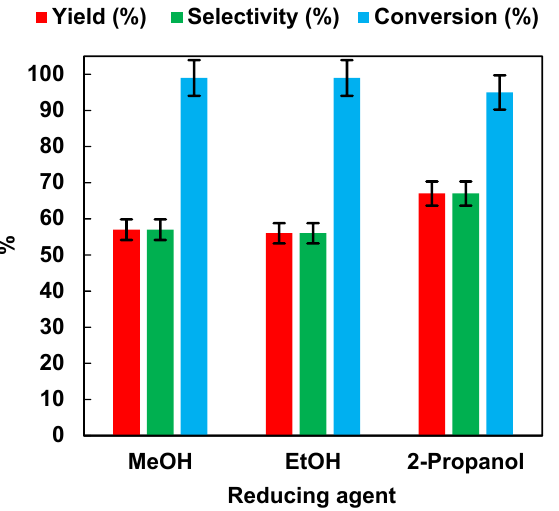
Figure 3. Effects of different hole scavengers on AN yield, AN selectivity, and NB conversion after 45 min of irradiation time. Error bar ±5%.